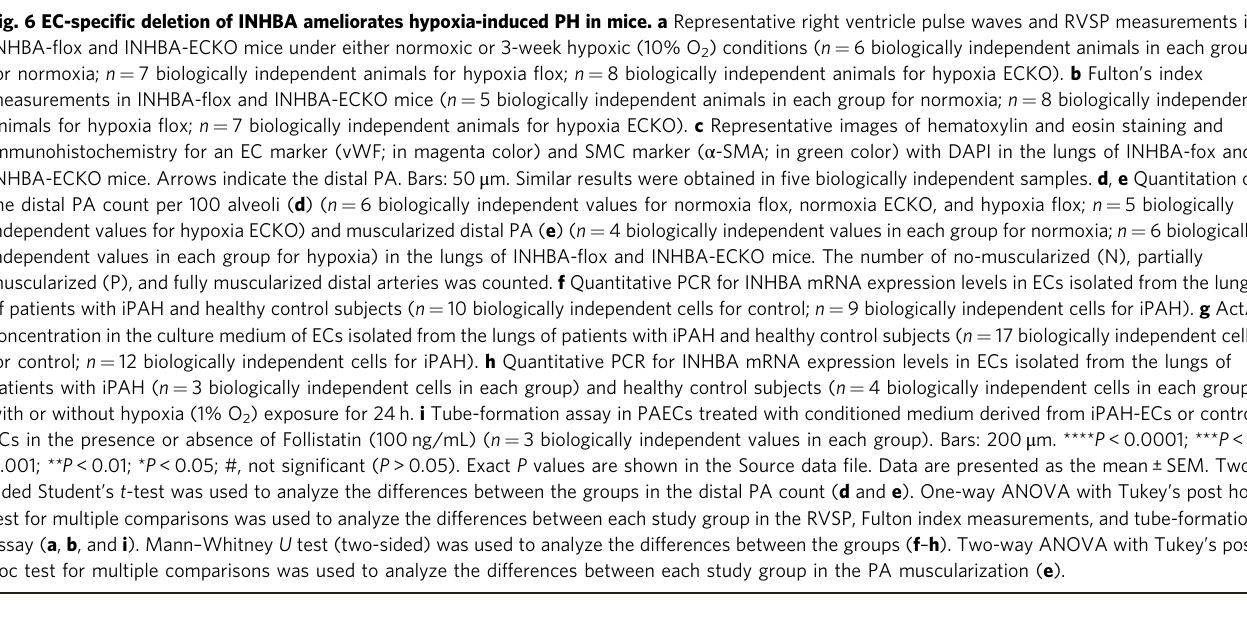
Fig. 6 EC-speci fi c deletion of INHBA ameliorates hypoxia-induced PH in mice. a Representative right ventricle pulse waves and RVSP measurements in INHBA- fl ox and INHBA-ECKO mice under either normoxic or 3-week hypoxic (10% O 2 ) conditions ( n = 6 biologically independent animals in each